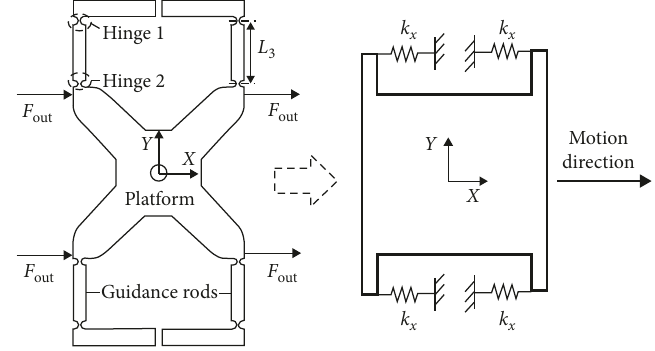
Figure 7: Mechanical model of the guidance mechanism.